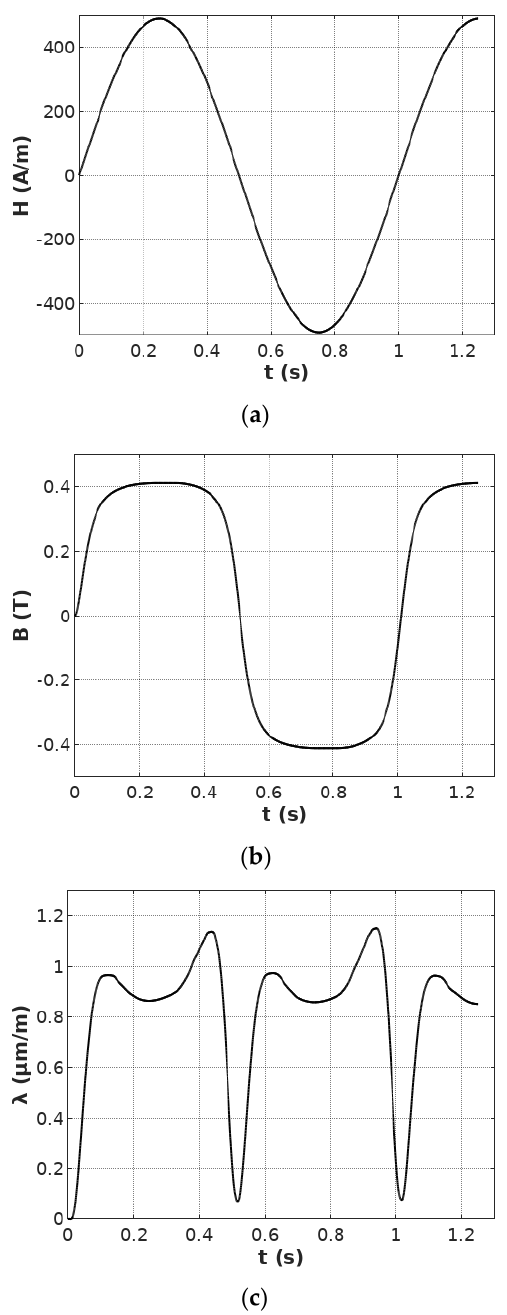
Figure 2. The results of measurements during the single measurement cycle: ( a ) Magnetizing field H , ( b ) flux density B , ( c ) magnetostriction λ